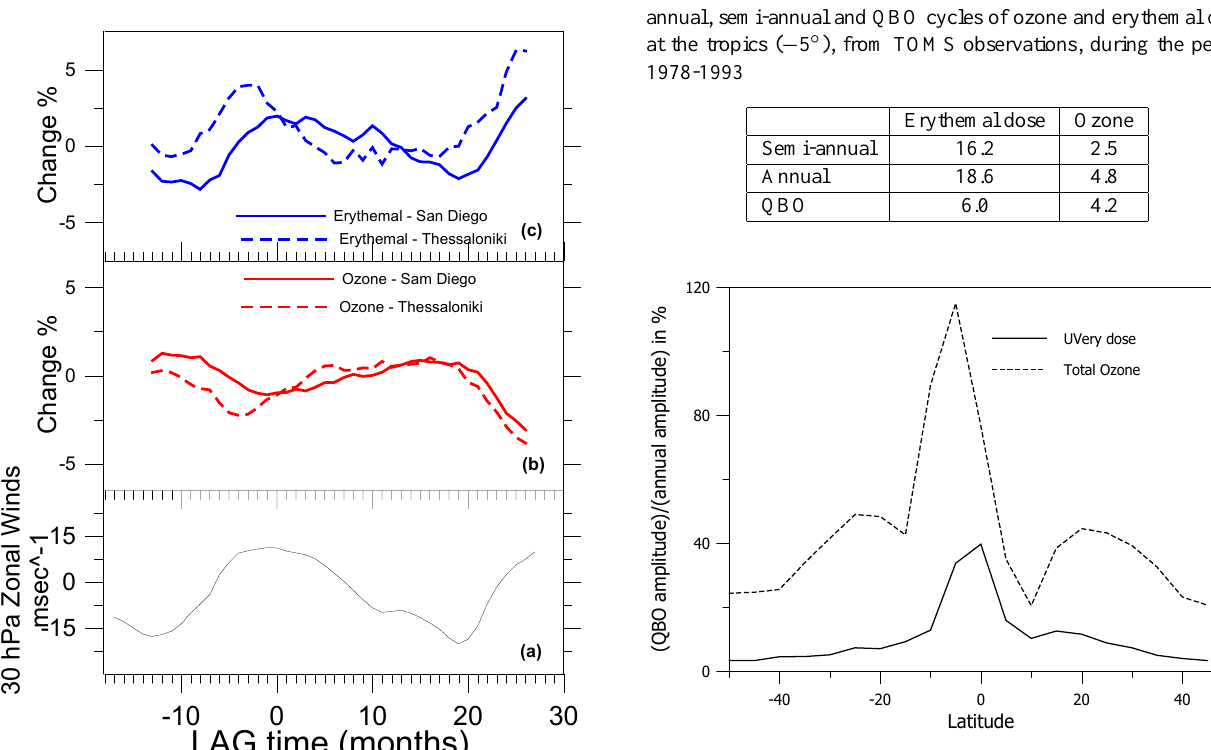
Fig. 5. Ratio of the QBO peak-to-peak amplitude relative to the amplitude of the annual cycle as a function of latitude, based on TOMS Uvery exposure estimates (continuous line) and on total ozone (dashed